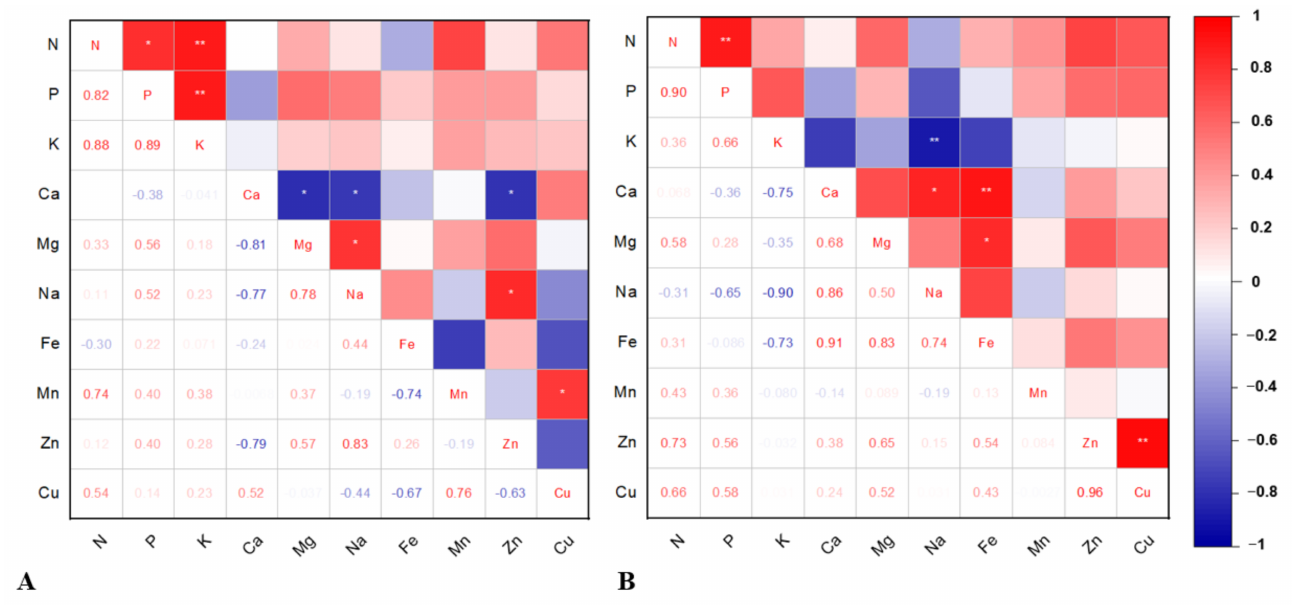
Figure 5. Correlation matrix between total plant nutrient concentrations in autumn-planted ( A ) and spring-planted ( B ) strawberry. The size and colour intensity of squares are proportional to Pearson’s correlation coefficients. Red squares indicate positive correlations, while blue are negative correlations. In the correlogram scale from − 1 to +1, Pearson’s correlation coefficient for variables is on the vertical and horizontal axis. * indicates values that are statistically different at p < 0.05 and ** at p < 0.01. The correlation matrix was generated from correlplot application in the OriginLab 2021 software for Windows (OriginLab Corp. Northampton, MA,